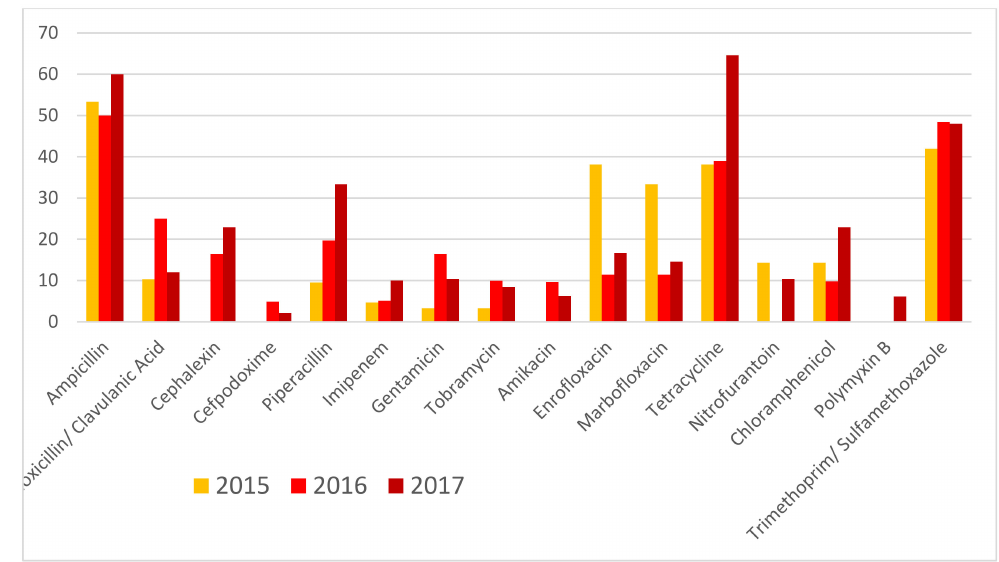
Figure 3. Variations in the percentages of resistant during the three years of the study.